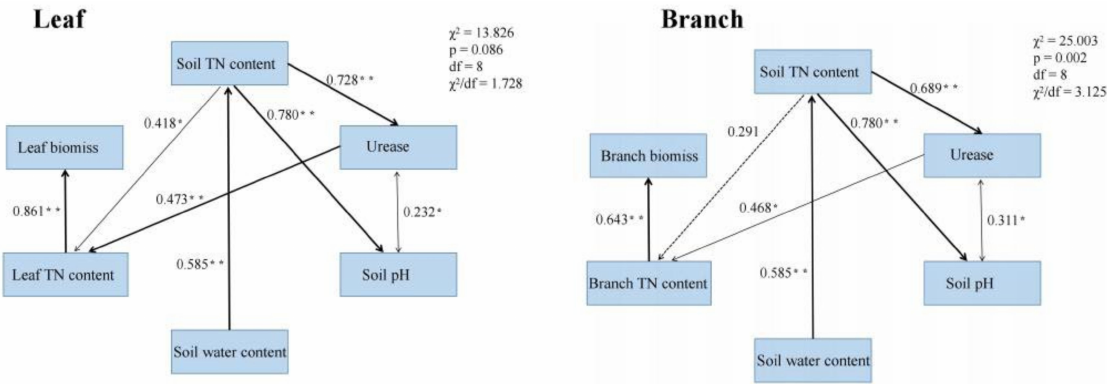
Figure 6. Path analysis of leaf and branch biomass. Standardized path coefficients are shown next to the arrows. Asterisks (* and **) indicate significance at p ≤ 0.05 and ≤ 0.01, respectively. The goodness of fit statistics are displayed next to the modeling